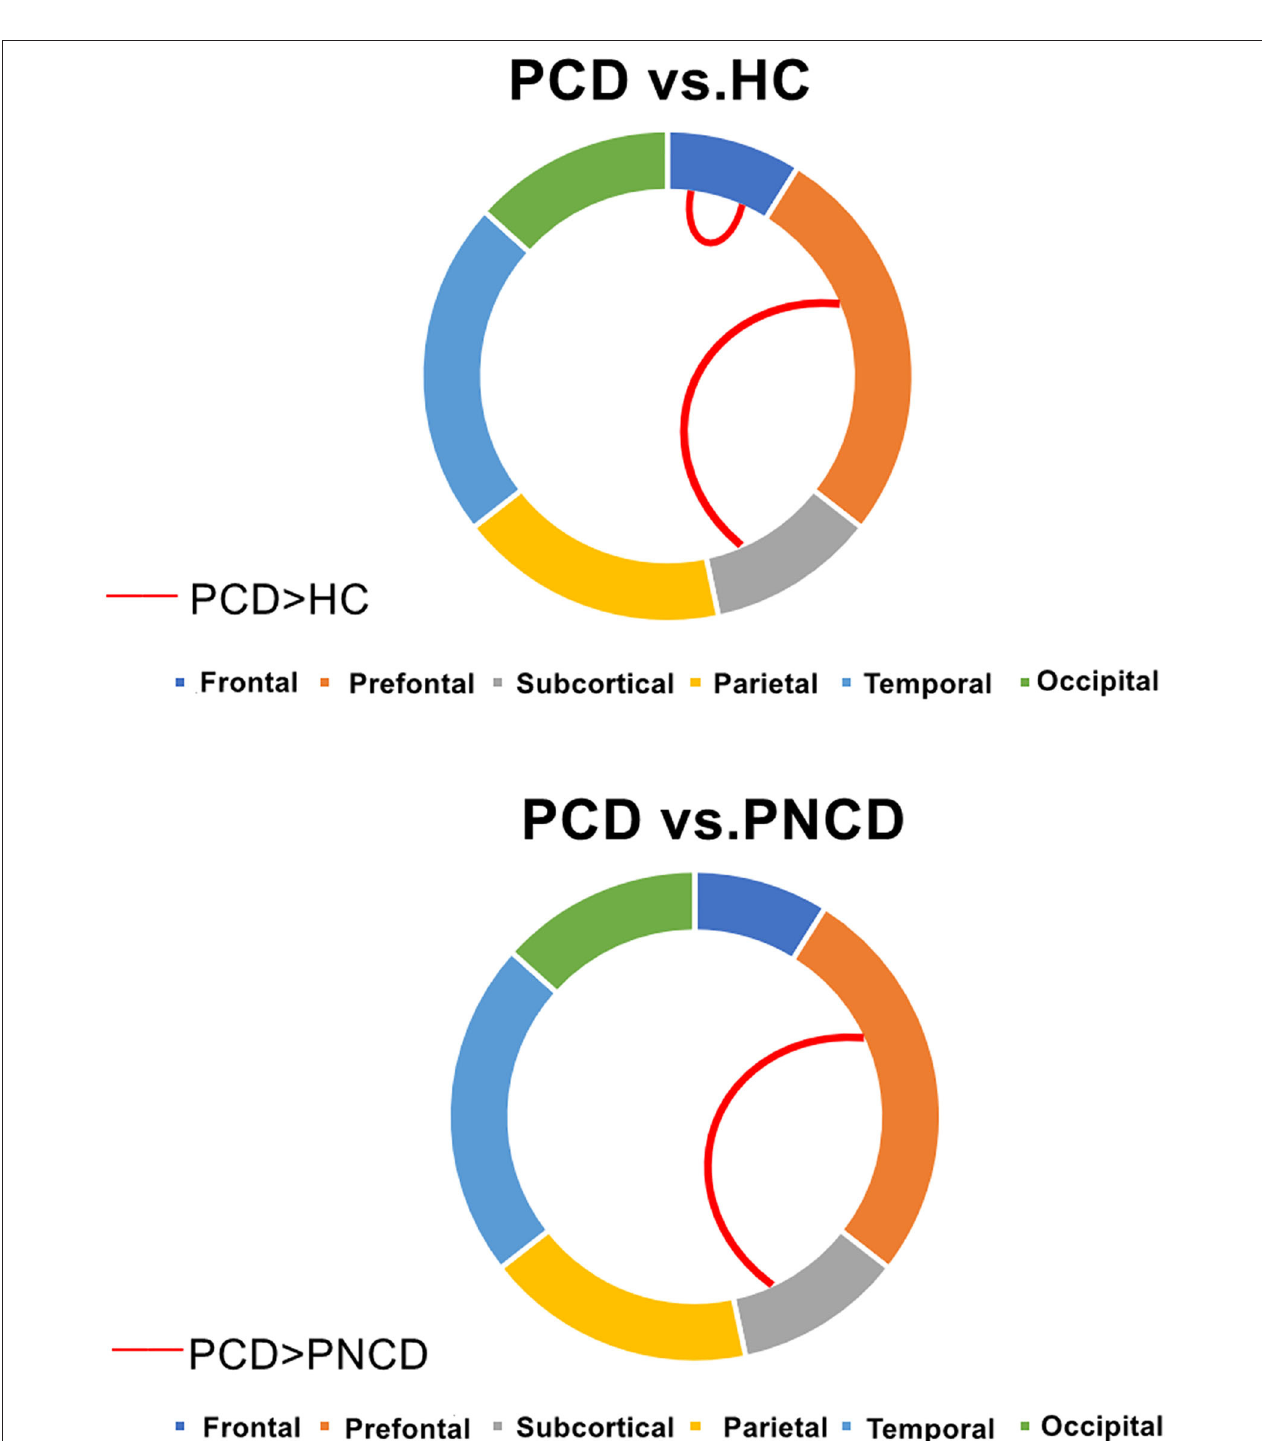
FIGURE 3 | Presbycusis patients with cognitive decline, presbycusis patients without cognitive decline, and healthy controls have significant differences in intra- and inter-modular connections. PCD, presbycusis patients with cognitive decline; PNCD, presbycusis patients with no cognitive decline; HC, healthy controls. Red lines represented significantly more